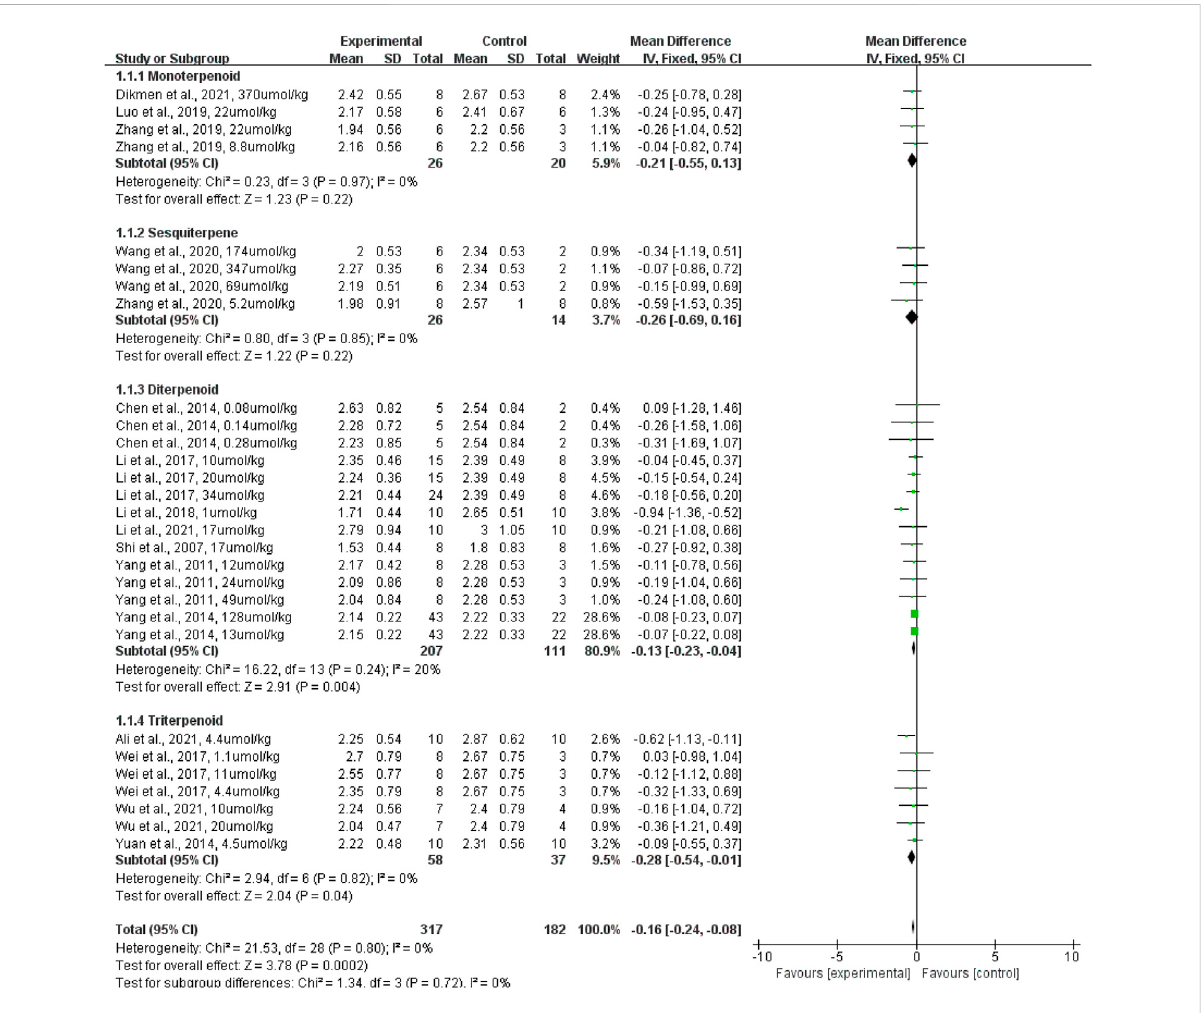
FIGURE 4 The forest plot of therapeutic ef fi ciency of terpenoids on lung wet-to-dry weight ratio. Subgroup analyses investigated the therapeutic ef fi ciency of monoterpenoid, sesquiterpene, diterpenoid, and triterpenoid. CI, con fi dence interval; IV, inverse variance; Std, standard; SD, standard